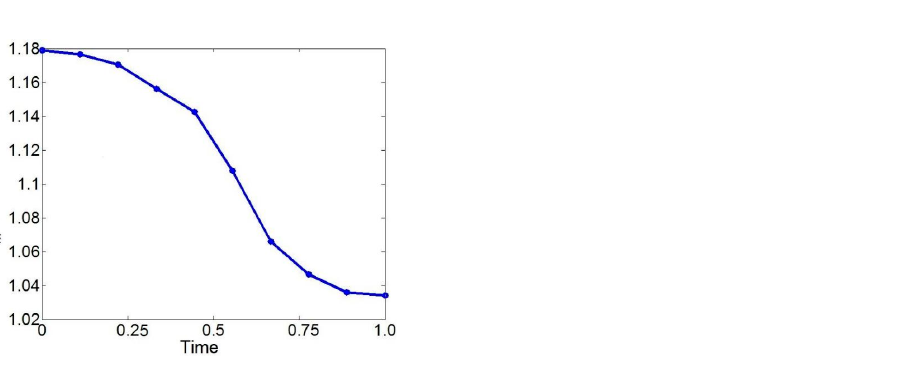
Figure 4. The deformation of an RBC under capillary flow in a cylindrical pulmonary vessel and the uptake of CO during this process.